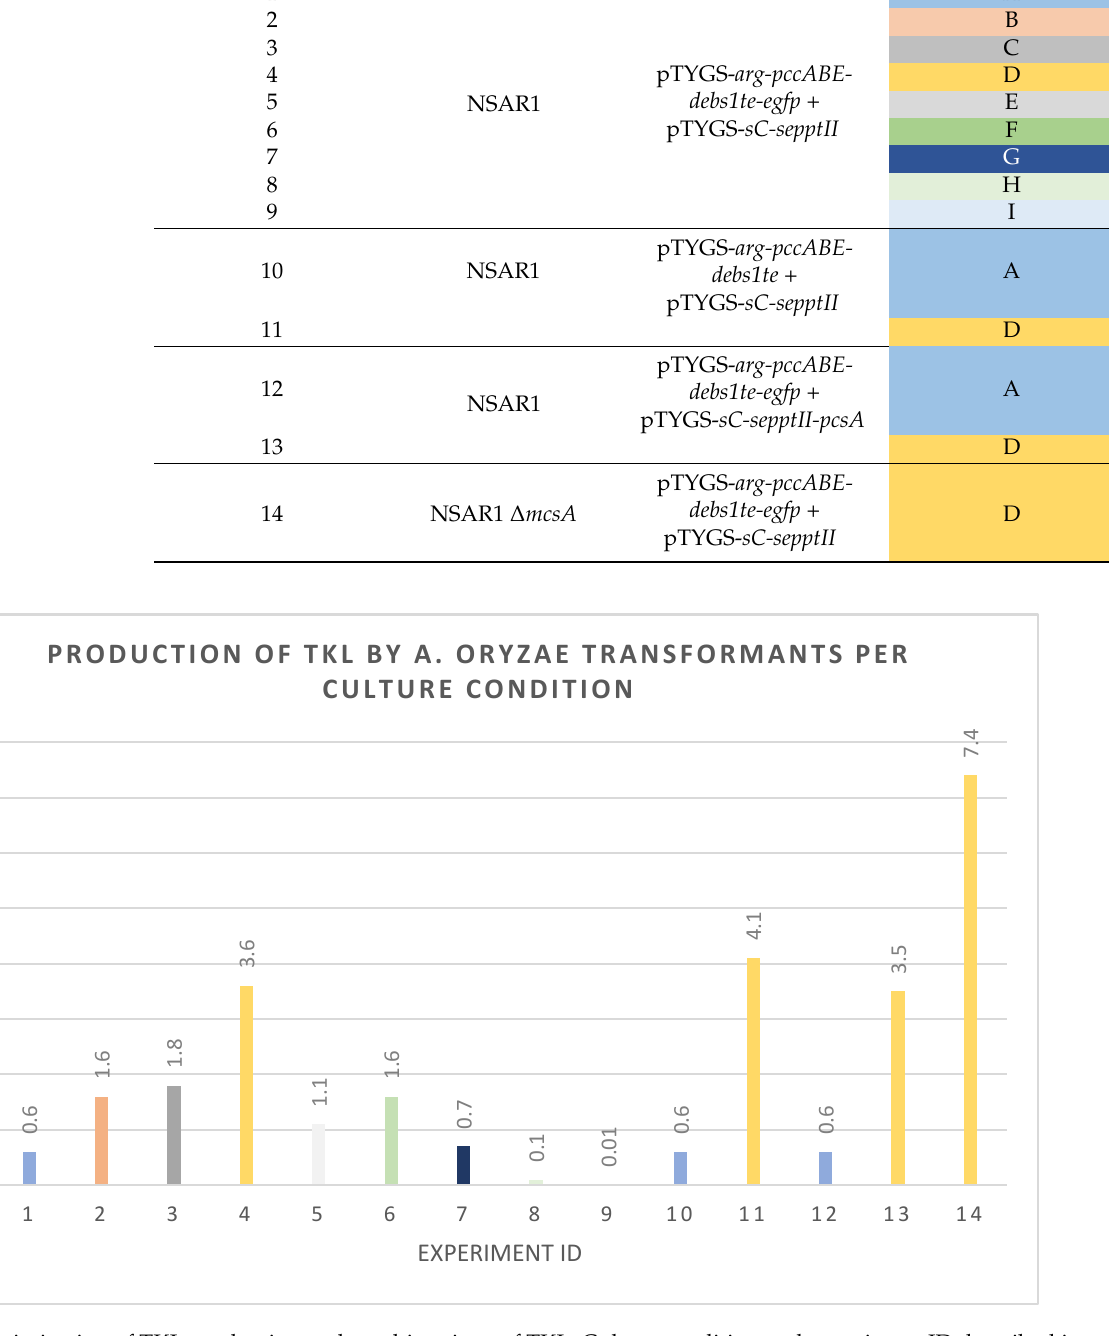
Figure 5. Optimization of TKL production and resulting titers of TKL. Culture condition and experiment ID described in Tables 1 and 2.